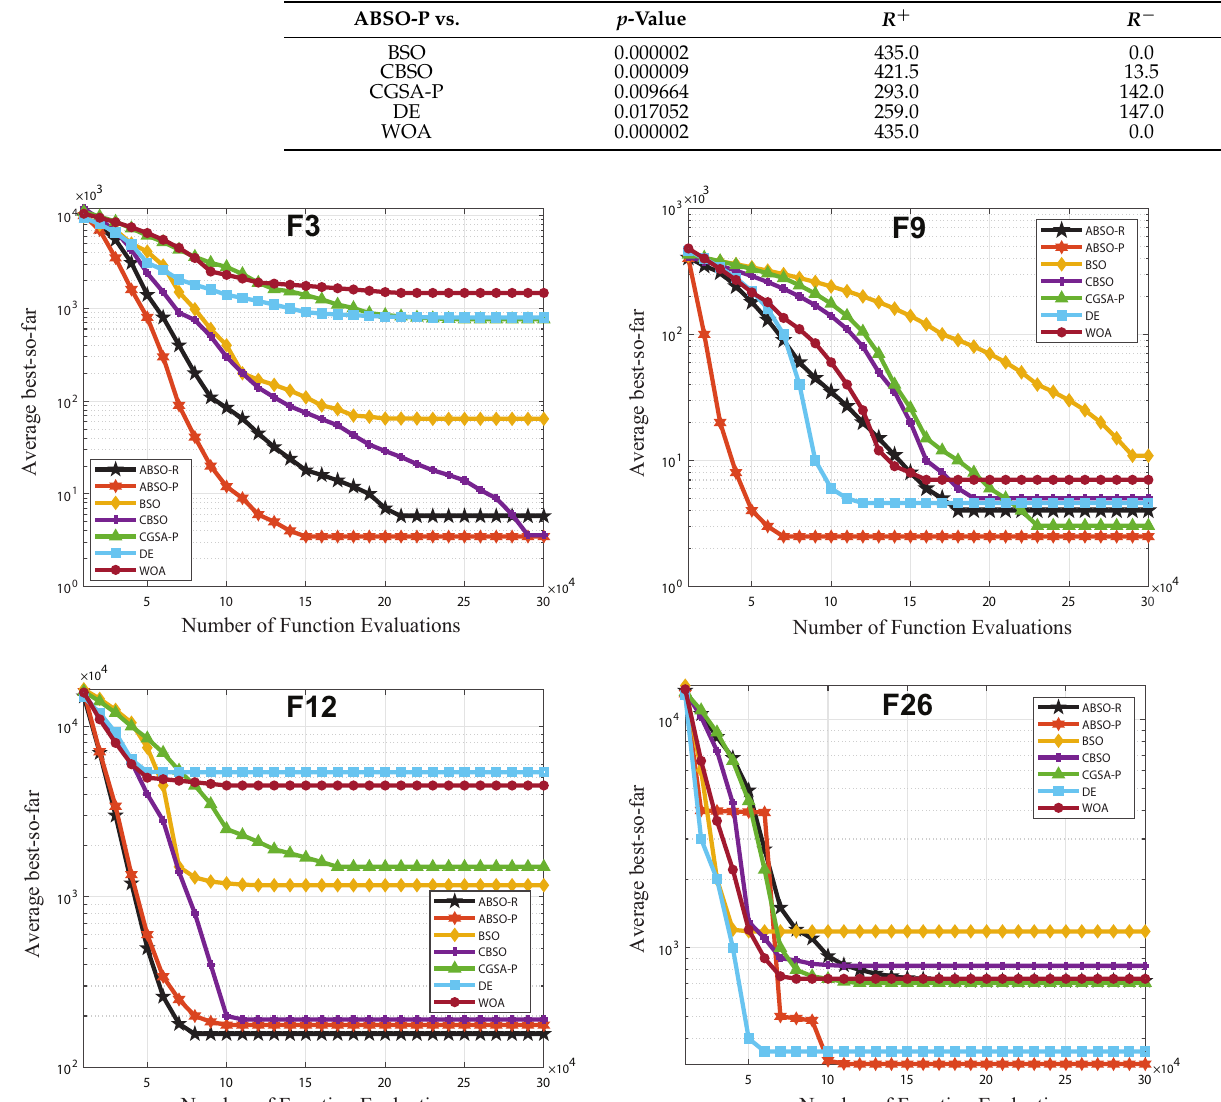
Figure 2. Convergence of the optimal solution of the proposed algorithm on test functions F3, F9, F12, and